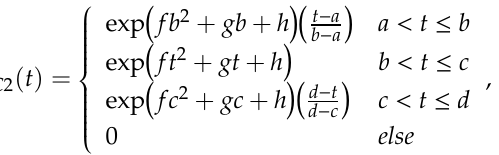
Figure 11. ( a ) Mean curves and ( b ) variance curves of the four bathymetric points. The time offset indicates the offset of the waveform from the peak of the surface signal.